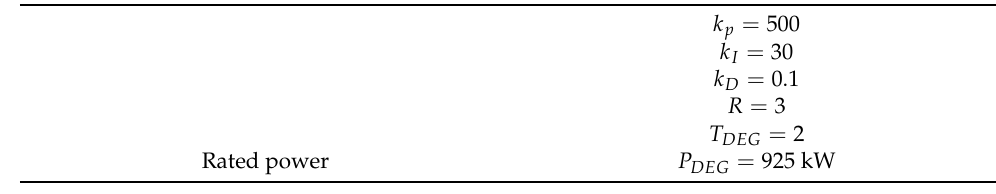
Table A2. Diesel engine parameters [29].